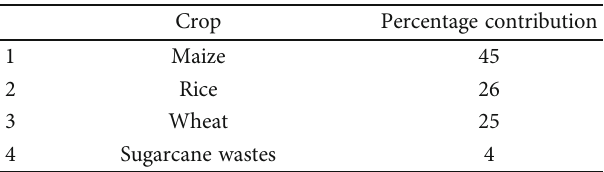
Table 2: Four leading crop residues to GHG emissions in CO gigagram